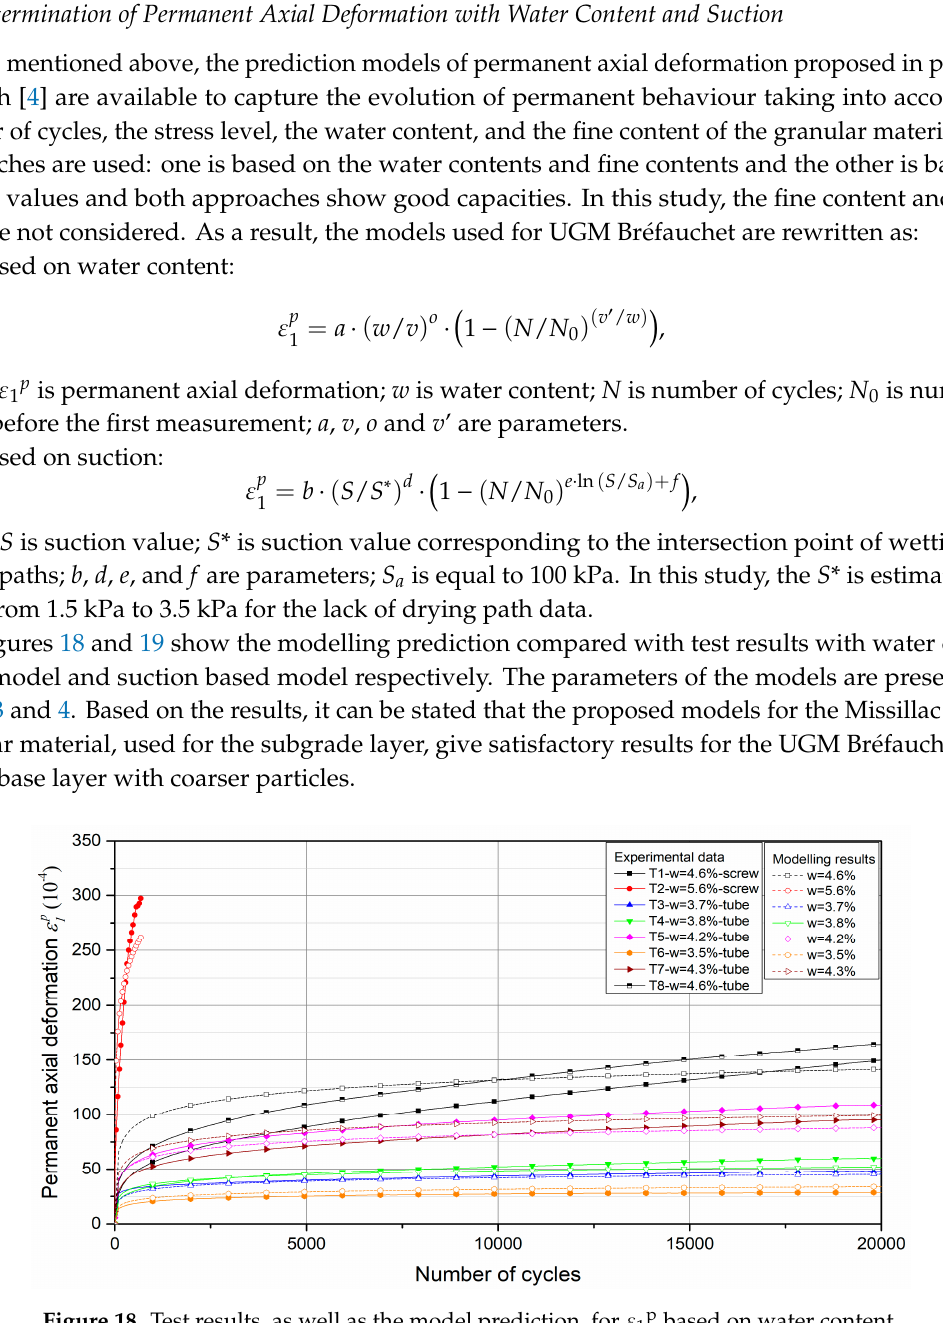
Figure 18. Test results, as well as the model prediction, for 1p based on water content.